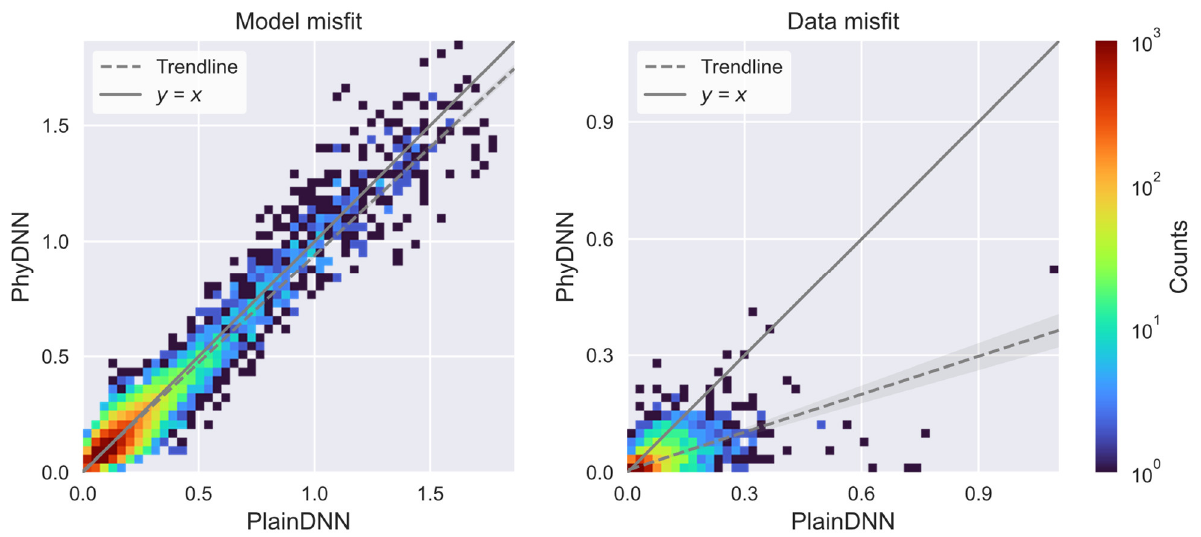
Figure 6. The model and data misfit scatter density plots between the PlainDNN and PhyDNN for the test set. Table 2. Mean model and data misfits of the test set for the PlainDNN and PhyDNN.